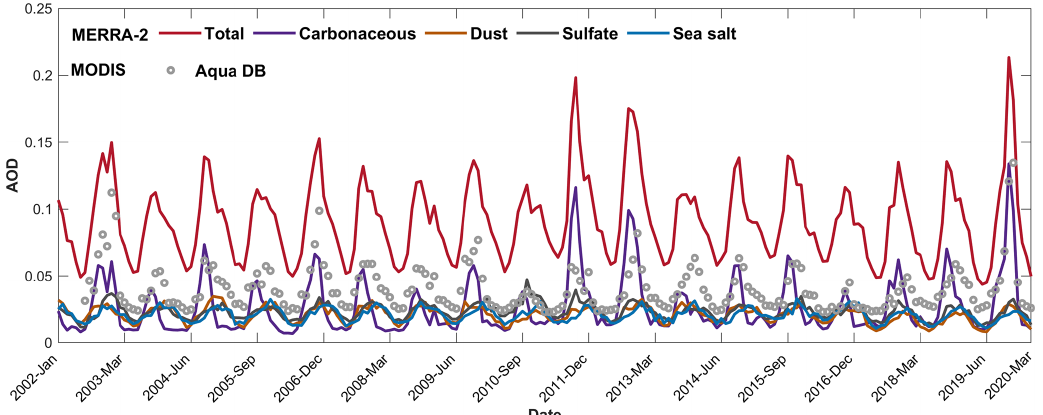
Figure 8. Time series of monthly averaged carbonaceous, dust, sulfate, and sea salt AODs from MERRA-2, as well as the Aqua MODIS DB AOD, in Australia from January 2002 to May